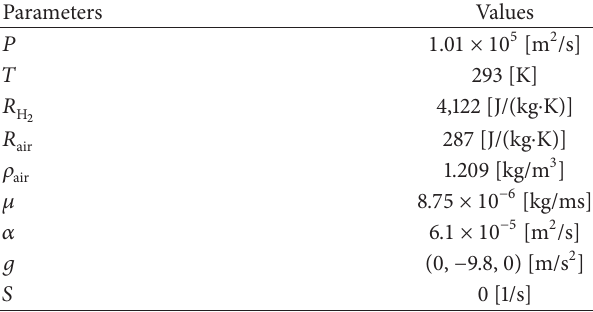
Table 1: The material